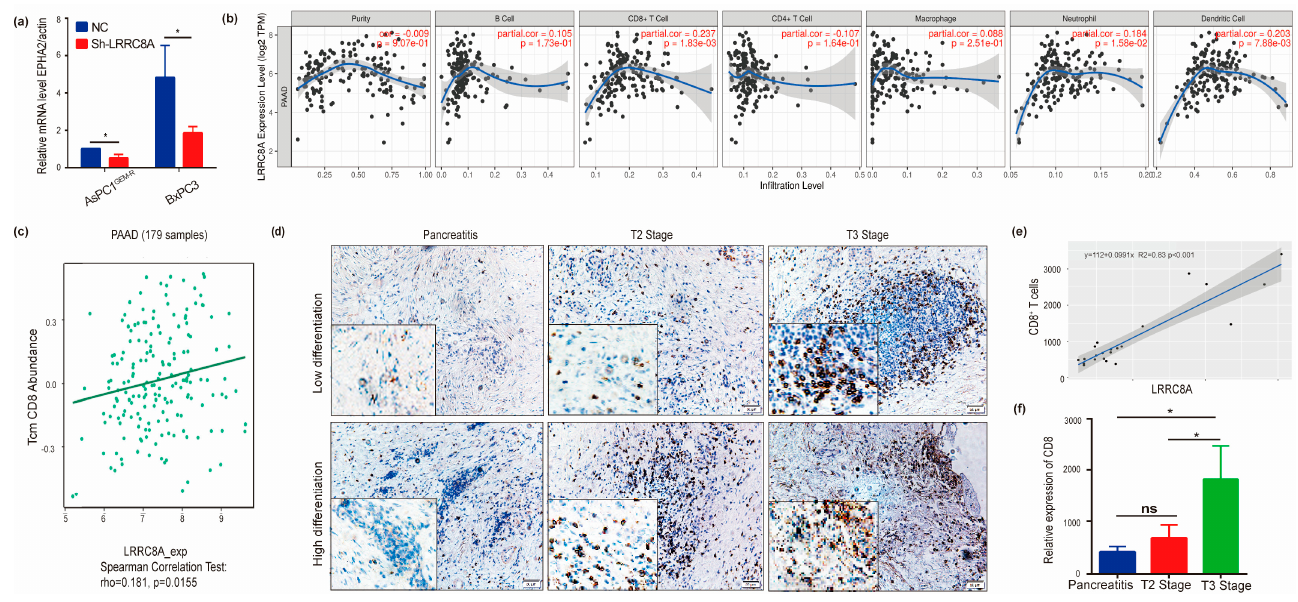
Figure 5. Immune infiltration analysis of LRRC8A in PAAD. ( a ) EPHA2 expression decreased in BxPC3 ( p * < 0.05) and AsPC1 GEM-R cells ( p * < 0.05) after LRRC8A knockdown; ( b ) immune infiltration of LRRC8A in PAAD; ( c ) correlation analysis of LRRC8A and CD8 + T cells; ( d ) representative immunohistochemical results of CD8 in patients with PAAD; ( e ) correlation analysis of LRRC8A and EPHA2 in patients with PAAD; ( f ) quantitative analysis results of Figure 5d. ns: not